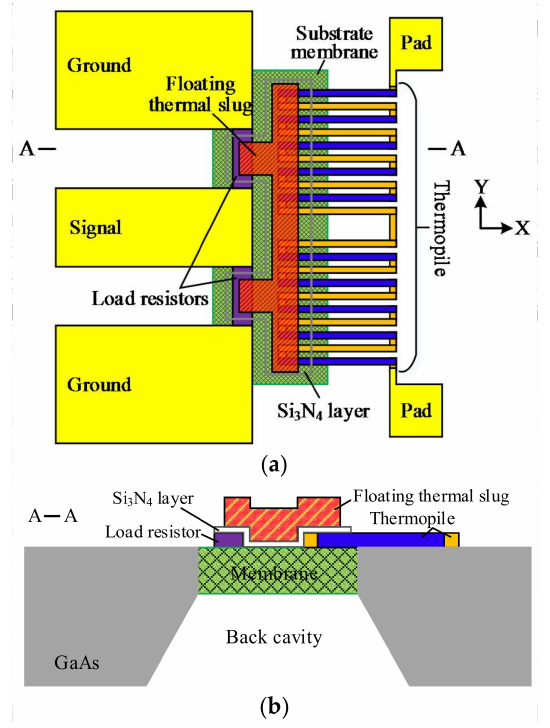
Figure 1. Schematic diagrams of the proposed micro-electro-mechanical systems (MEMS) thermoelectric microwave power sensor with dual thermal flow paths (floating thermal slug and back cavity) in the GaAs monolithic microwave integrated circuits (MMIC) process. ( a ) Top view; ( b ) Cross-sectional